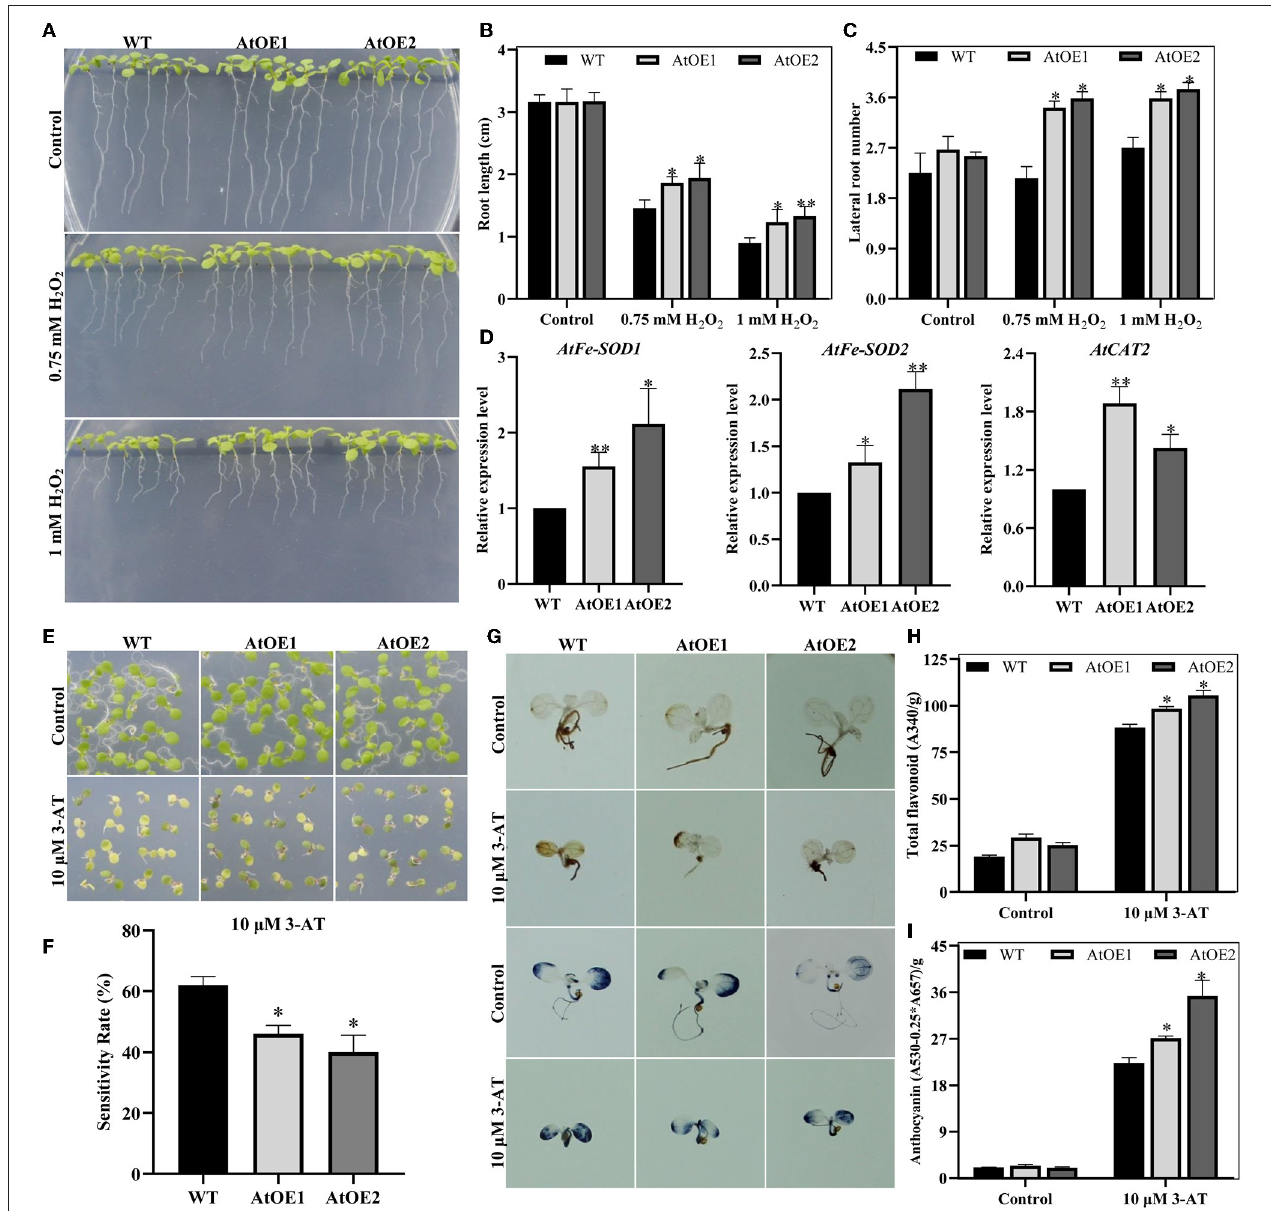
FIGURE 8 | Pn2-ODD1 conferred the tolerance to oxidative stress in Arabidopsis . (A) Primary root length of Arabidopsis seedlings under oxidative stress. (B,C) Statistical analysis of root length and lateral root number as shown in (A) . (D) Expression patterns of ROS-scavenging protein (i.e., AtFeSOD1 , AtFeSOD2 , and AtCAT1 ) in Arabidopsis under oxidative stress. (E,F) Growth phenotype and statistical analysis of WT and AtOE lines under the treatment of 10 µ M 3-AT for 7 days. (G) 3,3 ′ -diaminobenzidine (DAB) and nitrobluetetrazolium blue chloride (NBT) staining. (H,I) Content of total flavonoids and anthocyanins in WT and AtOE lines under 3-AT treatment for 7 days. Asterisk (*) represents a significant difference between the WT plants and AtOE lines (Student’s t -test, * P < 0.05, ** P <